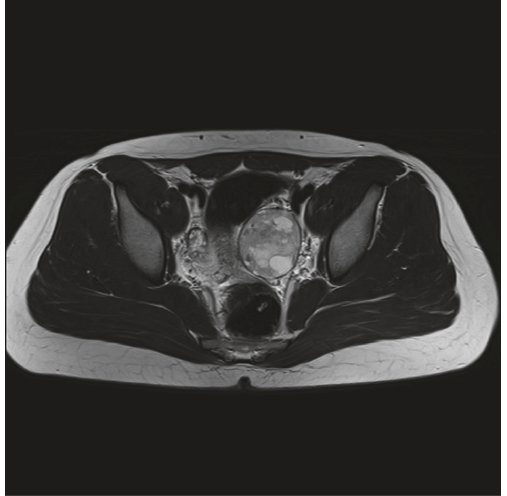
Figure 2: MRI image of ovarian lesion.